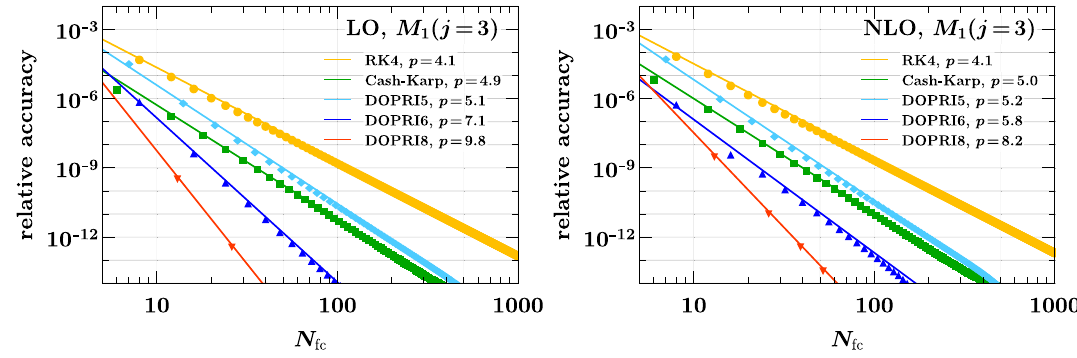
with maximum step size h = 0 . 1 is used to solve the evolution equa- tions. The same grid in x is used as for the benchmark comparison in Sect. 5.2